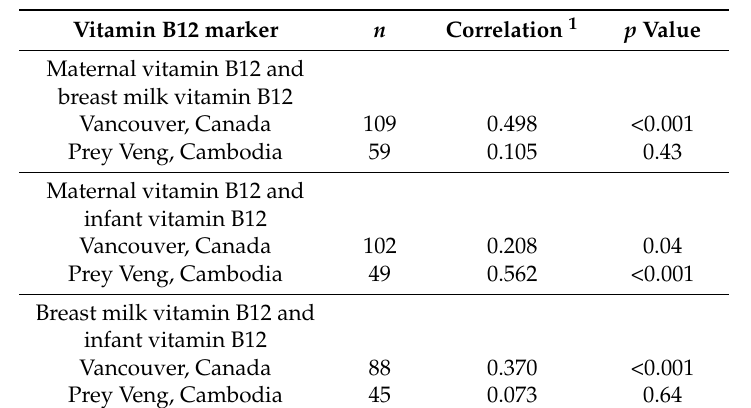
Table 2. Correlations between maternal, infant, and milk total vitamin B12 concentrations among samples of mother–infant dyads in Canada and Cambodia.